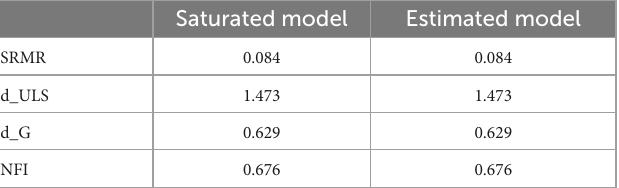
TABLE 5 Model fit.